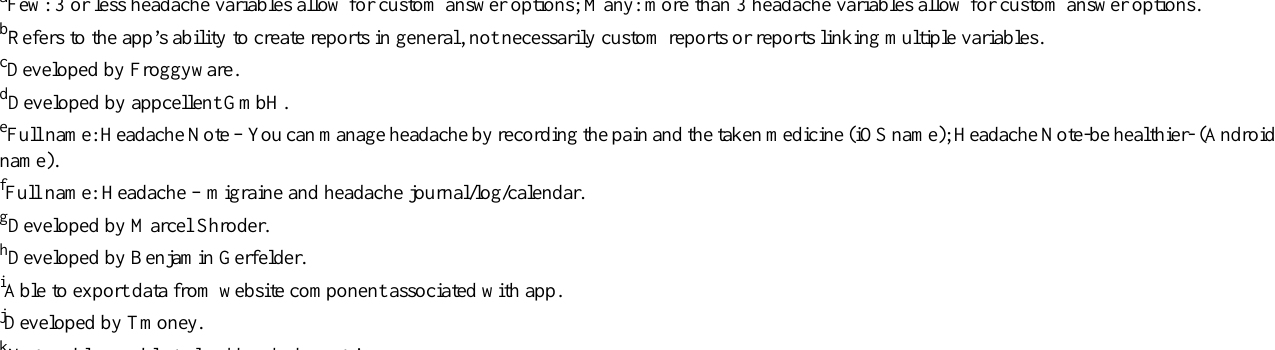
Figure 1 for a screenshot of the 3 highest scoring apps. Only 7 of the 38 available apps met 4 or more of the app criteria. The median number of app criteria met was 2. Table 4 shows the number of apps meeting each